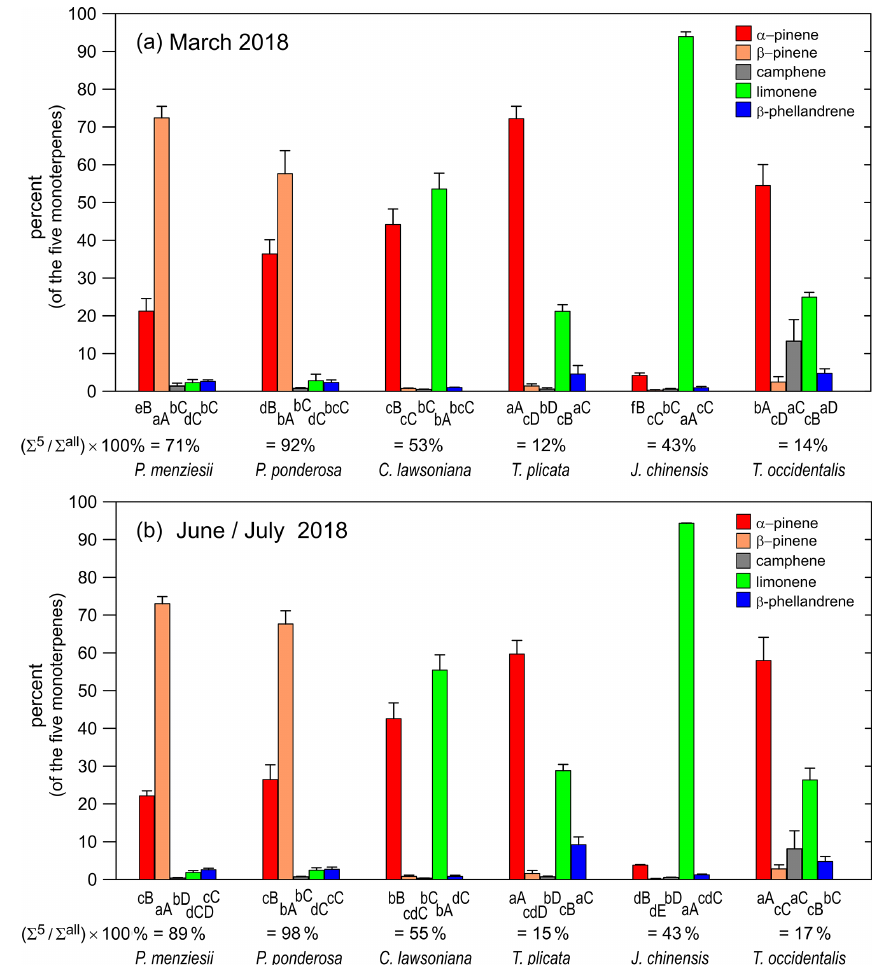
Figure 2. (a) Bar graph showing percentages among five monoterpenes in March 2018 for six nursery-purchased conifer species. Within a given species, the largest value is designated “A”; thereafter, a different capital letter indicates a significant difference between the monoter- penes. For a given monoterpene, the largest value is designated “a”; thereafter, a different lowercase letter indicates a significant difference between the species. The percentage values that the five monoterpenes represent as a sum relative to the sum of all detected monoterpenes ( = ((cid:54) 5 /(cid:54) all ) × 100%) are given. The error bars are ± 1SD. The data values are given in Table 2a. (b) Bar graph showing the percentages among five monoterpenes in June–July 2018 for six nursery-purchased conifer species. Within a given species, the largest value is designated “A”; thereafter, a different capital letter indicates a significant difference between the monoterpenes. For a given monoterpene, the largest value is designated “a”; thereafter, a different lowercase letter indicates a significant difference between the species. The percentage values that the five monoterpenes represent as a sum relative to the sum of all detected monoterpenes ( = ((cid:54) 5 /(cid:54) all ) × 100%) are given. The error bars are ± 1SD. The data values are given in Table